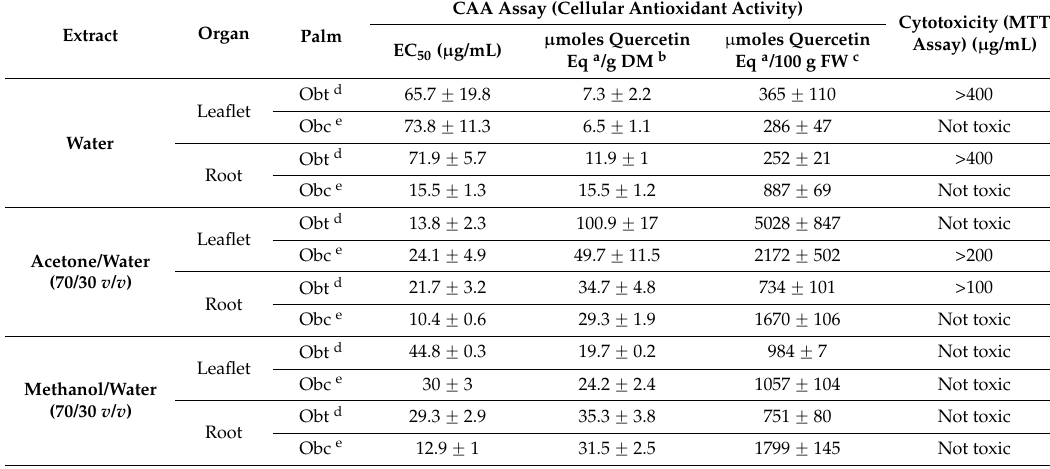
Table 3. Cytotoxicity and cellular antioxidant activity of O. bataua and O. bacaba extracts in NHDF cells.